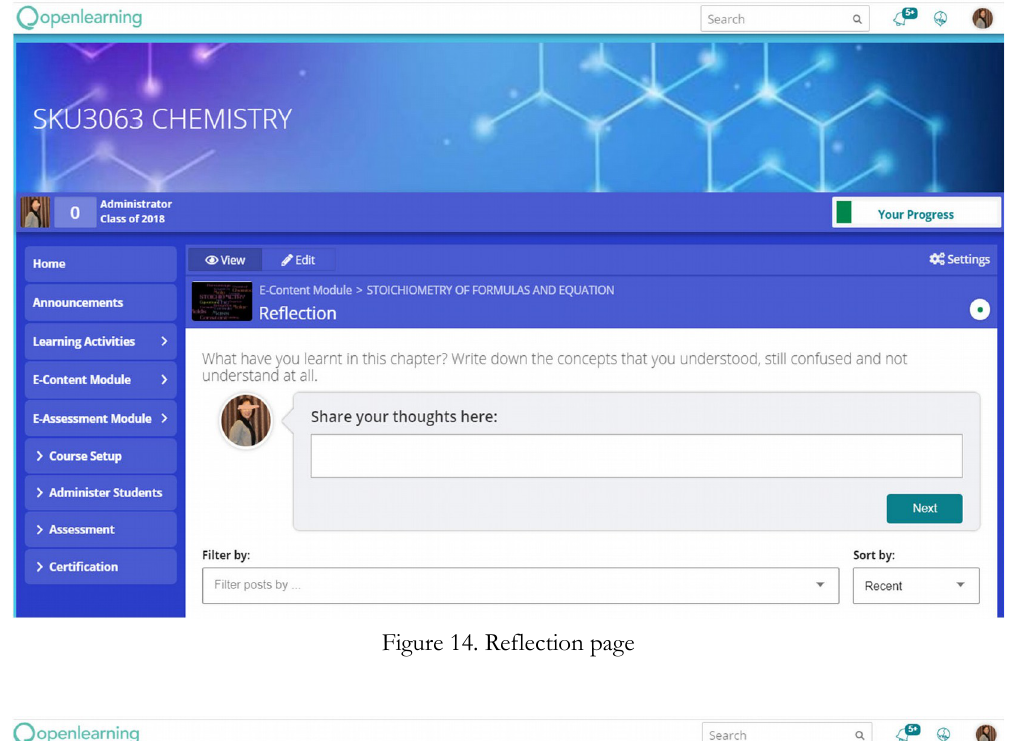
Figure 14. Reflection page